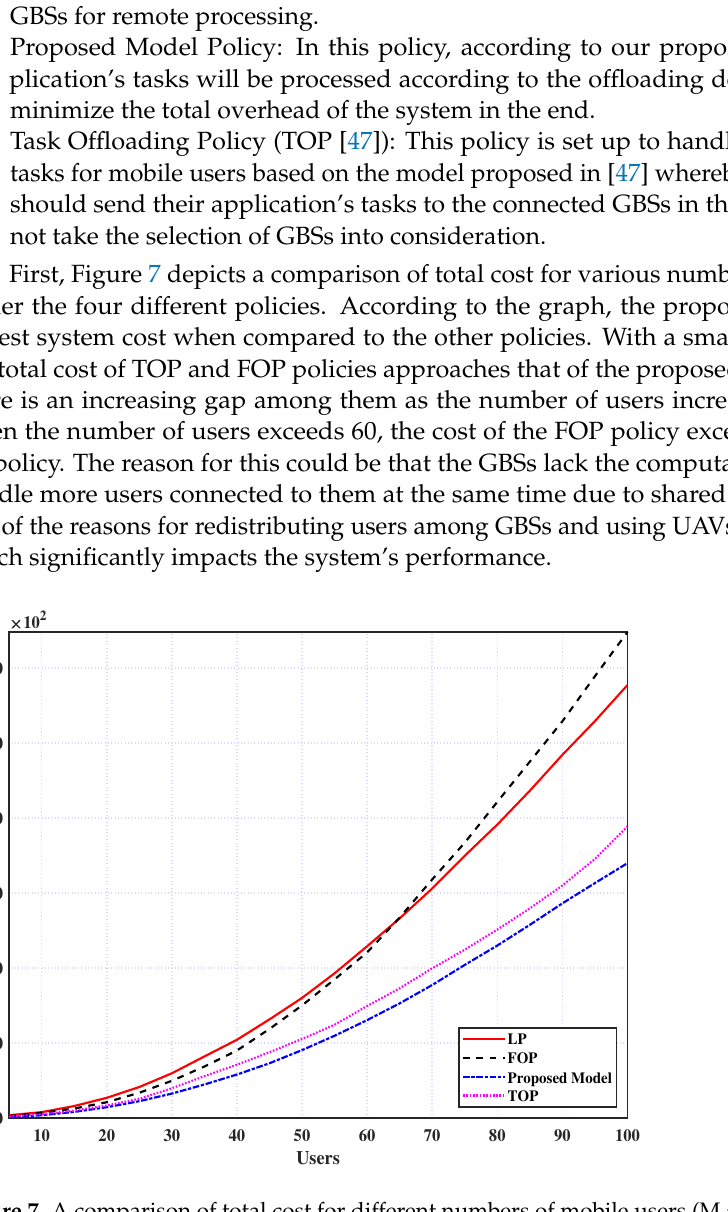
Figure 7. A comparison of total cost for different numbers of mobile users (M = 5, N =